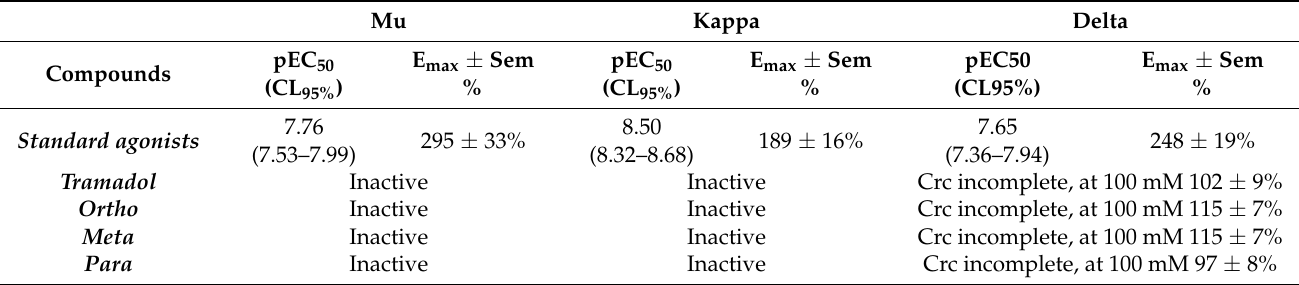
The standard agonists for mu, kappa and delta receptors were Dermorphin, Dynorphin A and DPDPE,